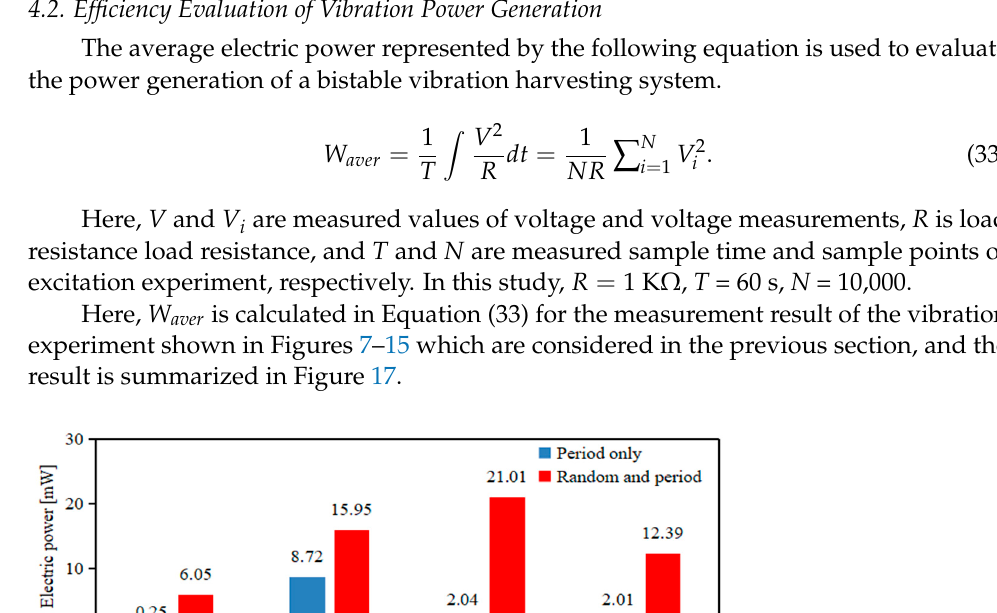
Figure 16. Results of comparing Ratio of displacement standard deviation of mass block to sup- port point. (The blue graph is the result of vibration with a periodic signal. The red graph is the result of vibration with random and periodic signals.)